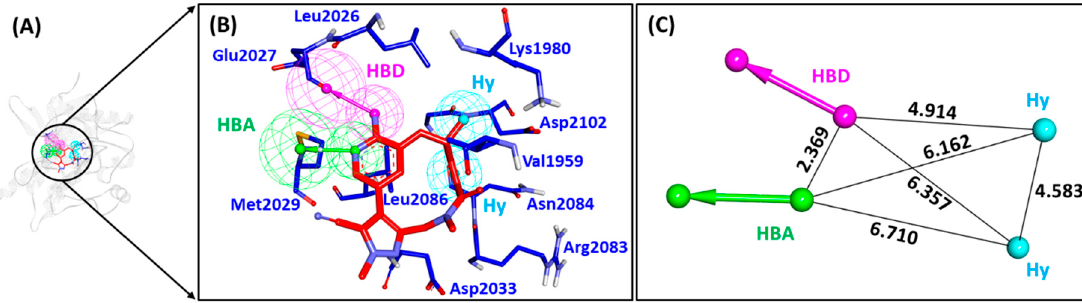
Figure 1. Receptor-ligand pharmacophore model- Pharmacophore_01. ( A ) Pharmacophore model generated at the catalytic site of c-ros oncogene1 (ROS-1) complexed with its co-crystallized ligand, lorlatinib. ( B ) ROS-1 selective inhibitor, lorlatinib mapping with essential residues of the ROS-1 active site via key pharmacophoric features- HBD, HBA and Hy. ( C ) Interfeature distance between the generated features of the pharmacophore. HBD (hydrogen bond donor); HBA (hydrogen bond acceptor); Hy